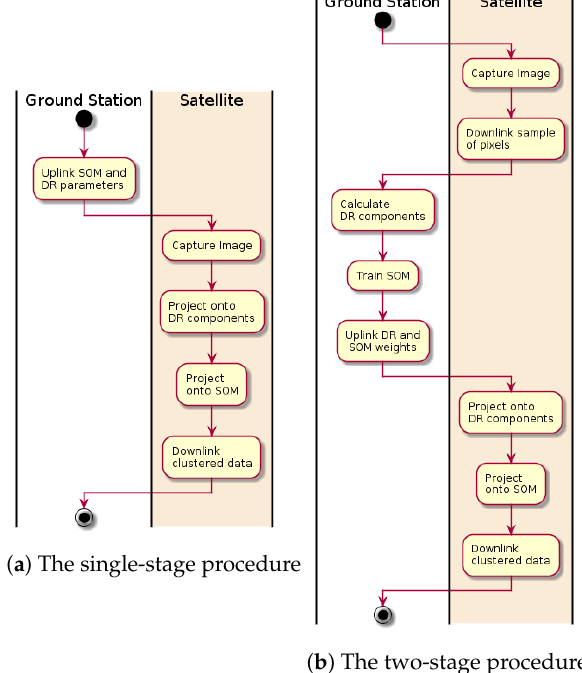
Figure 2. The two proposed operational procedures, which use Self-Organizing Maps to compress HSI data.